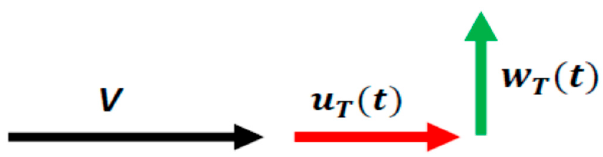
Figure 26. 2D turbulence components.